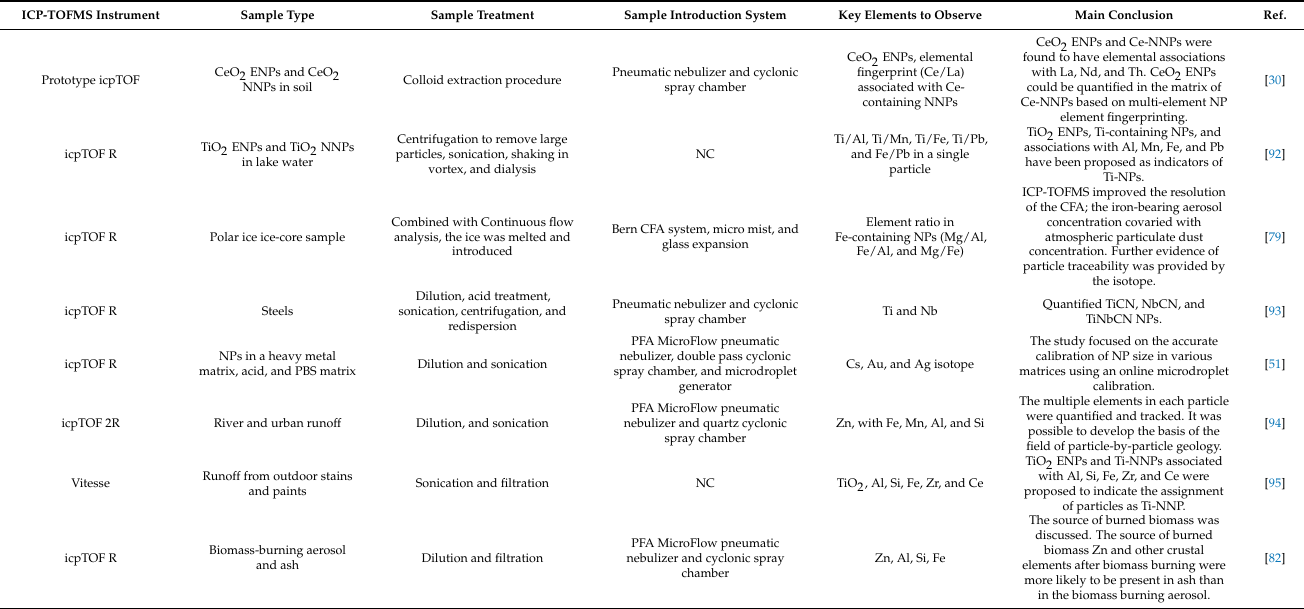
Table 1. The selected applications of